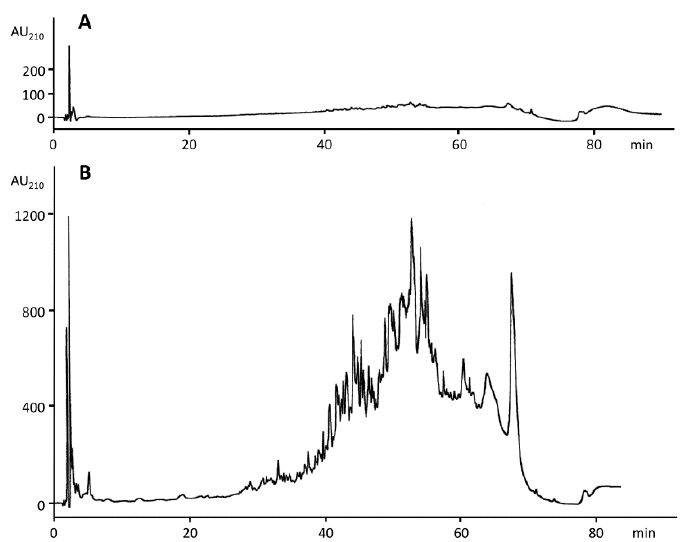
Figure 3. RP-HPLC (peptide system) of the peptic hydrolysis of gluten after incubation at 37 °C for 0 min ( A ) and 120 min ( B ). The ratio of enzyme to gluten to solvent was 1:25:100. AU 210 , absorbance units at 210 nm.